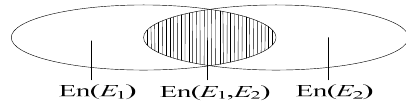
Figure 1. The relationships of two pieces of dependent evidence.